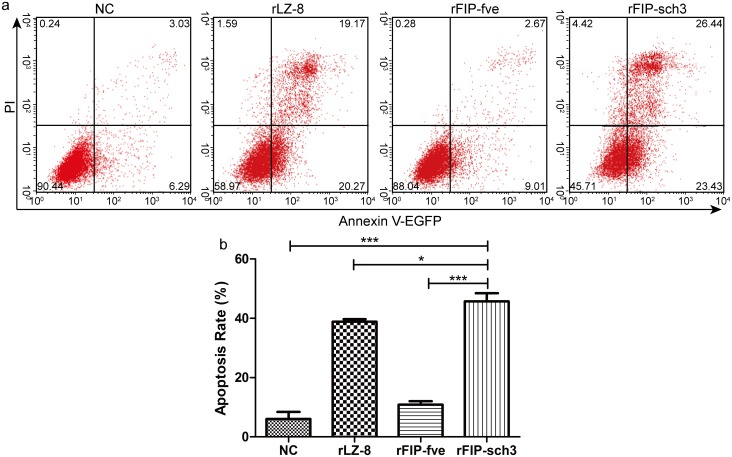
FACS analysis of apoptosis induced by rFIPs.A549 cells were subjected to treatments including PBS (negative control, NC), rLZ-8 (8 μg/mL), rFIP-fve (8 μg/mL), or rFIP-sch3 (8 μg/mL) at 37°C in a CO2 incubator for 24 h. The treated cells were then trypsinized, counted, and stained with annexin V-EGFP and PI, and the data were analysed using FACS. All experiments were performed in duplicate. (a) The data of one representative experiment are presented. The upper right quadrant (UR) represents late apoptotic cells that were stained with Annexin V-EGFP and PI, and the lower right quadrant (LR) represents early apoptotic cells that were stained with Annexin V-EGFP. (b) Phase percentages for the UR quadrant and LR quadrant are depicted on the bar graph. Each bar represents the mean ± SD (n = 3). *p < 0.05; ***p < 0.001, compared to the NC.